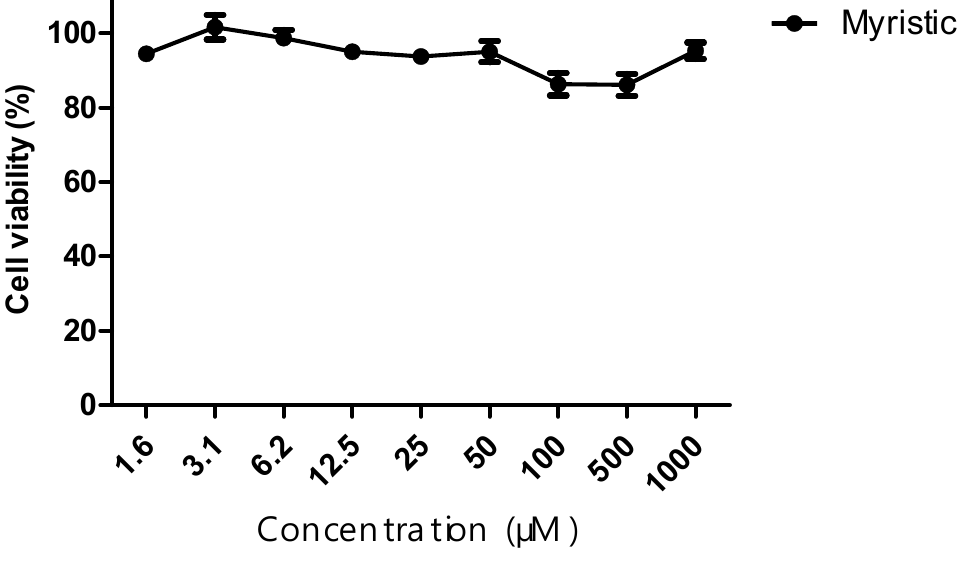
Figure 2. Cytotoxic activity of the myristicin compound. Assay performed with the NCI/ADR-RES tumor line, relating the percentage of cell viability versus concentration of myristicin, after 48 h of incubation.